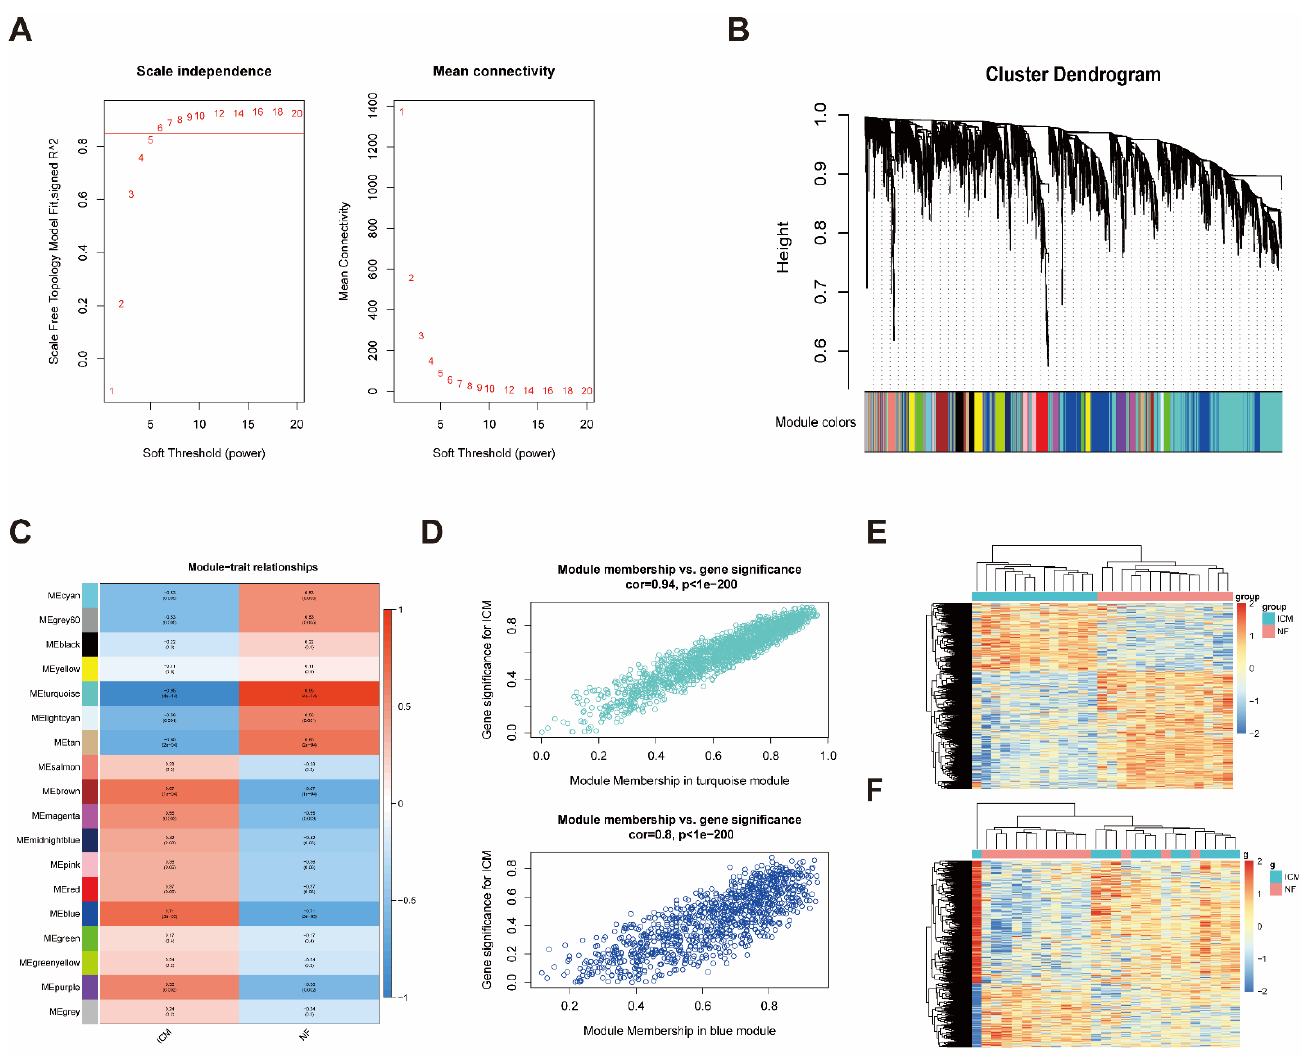
Figure 2. Weighted gene co-expression network analysis (WGCNA) for GSE116250. ( A ) Plot of the scale-free index analysis (left) and mean connectivity analysis (right) for threshold powers of 1–20. β = 6 (scale-free R 2 , 0.85) was chosen as the soft threshold. ( B ) The cluster dendrogram of genes in the WGCNA network, together with assigned module colors. ( C ) Module-clinical trait association analysis. Each column corresponds to a clinical trait, each row to a module. Each grid contains the corresponding correlation (upper) and p -value (lower). The table is color-coded by correlation according to the right color legend. The correlation coefficient of module and clinical trait is between − 1 and 1, and the association is positive related with the absolute value. ( D ) Scatterplot of GS for ICM versus MM in the turquois (upper) and blue (lower) modules. ( E ) The heatmap of gene expression profile in the turquois module. ( F ) The heatmap of gene expression profile in the blue module. ICM, ischemic cardiomyopathy; NF, non-failing heart.